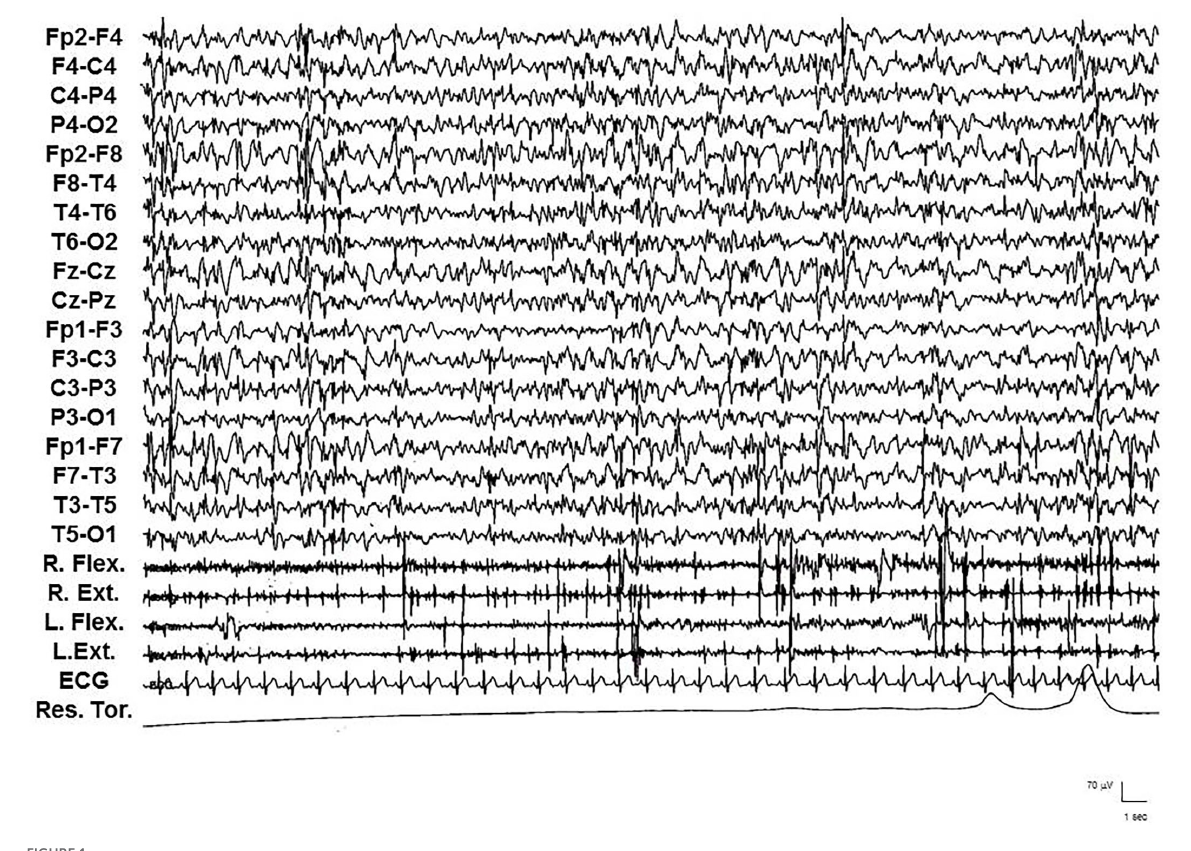
FIGURE1 Video-EEG/polygraphic features of interictal pattern in patient 2 during the late stage. Repetitive, multifocal, asymmetrical and asynchronous, rhythmic and arrhythmic, myoclonic jerks associated with diffuse, multifocal, and faster discharges of